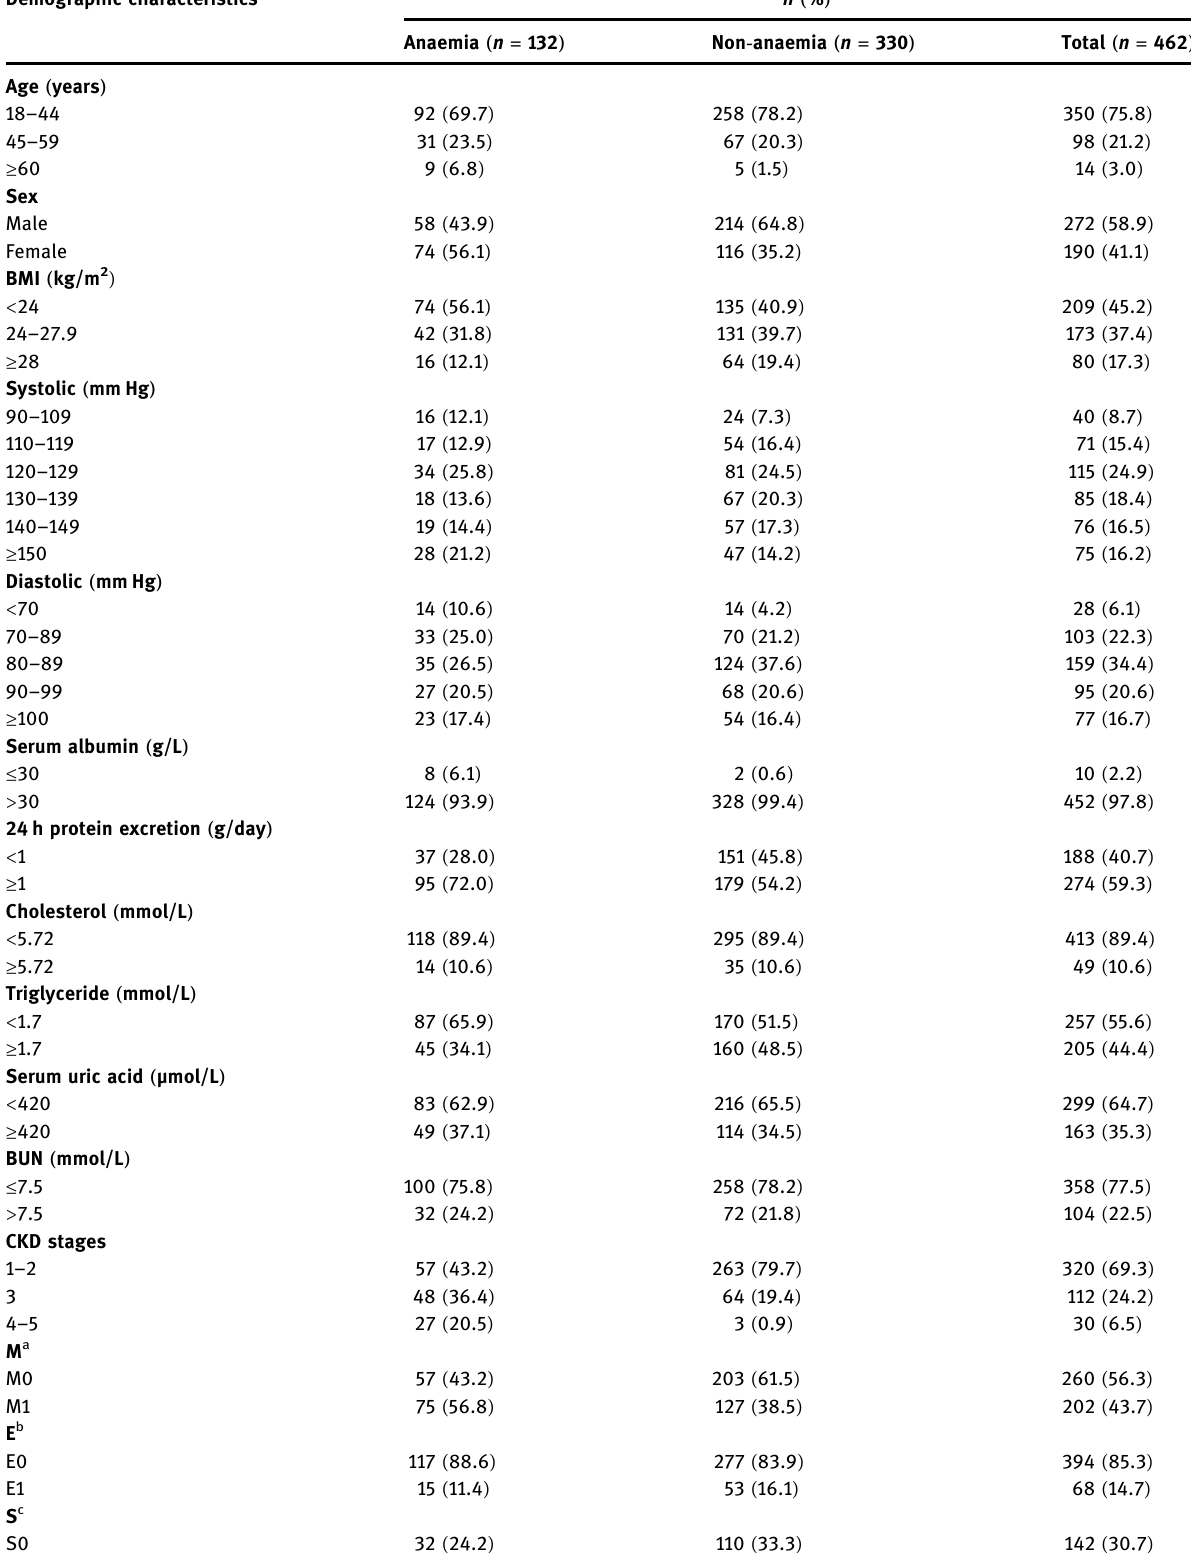
Table 1: Di ff erences between demographic and clinical characteristics of anaemia and non - anaemia groups Demographic